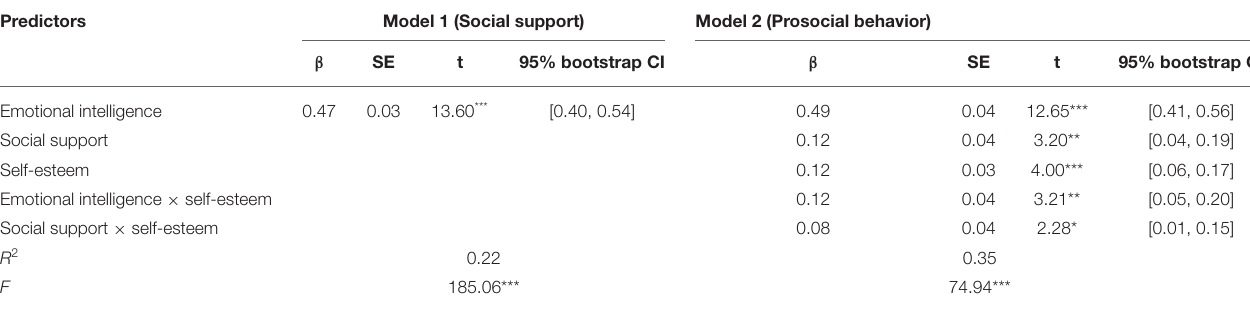
TABLE 3 | Testing the moderated mediation effect of self-esteem.